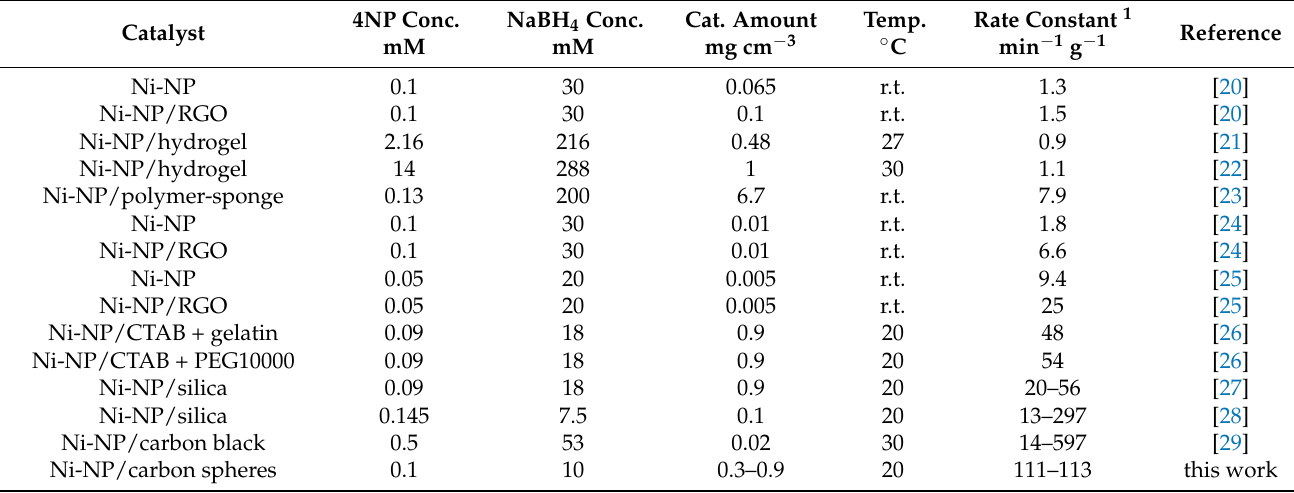
Table 2. Comparison of reaction conditions and rate constants, k = k app / m cat , for the reduction of 4NP with NaBH 4 at the presence of supported, composite or bare Ni NPs 1